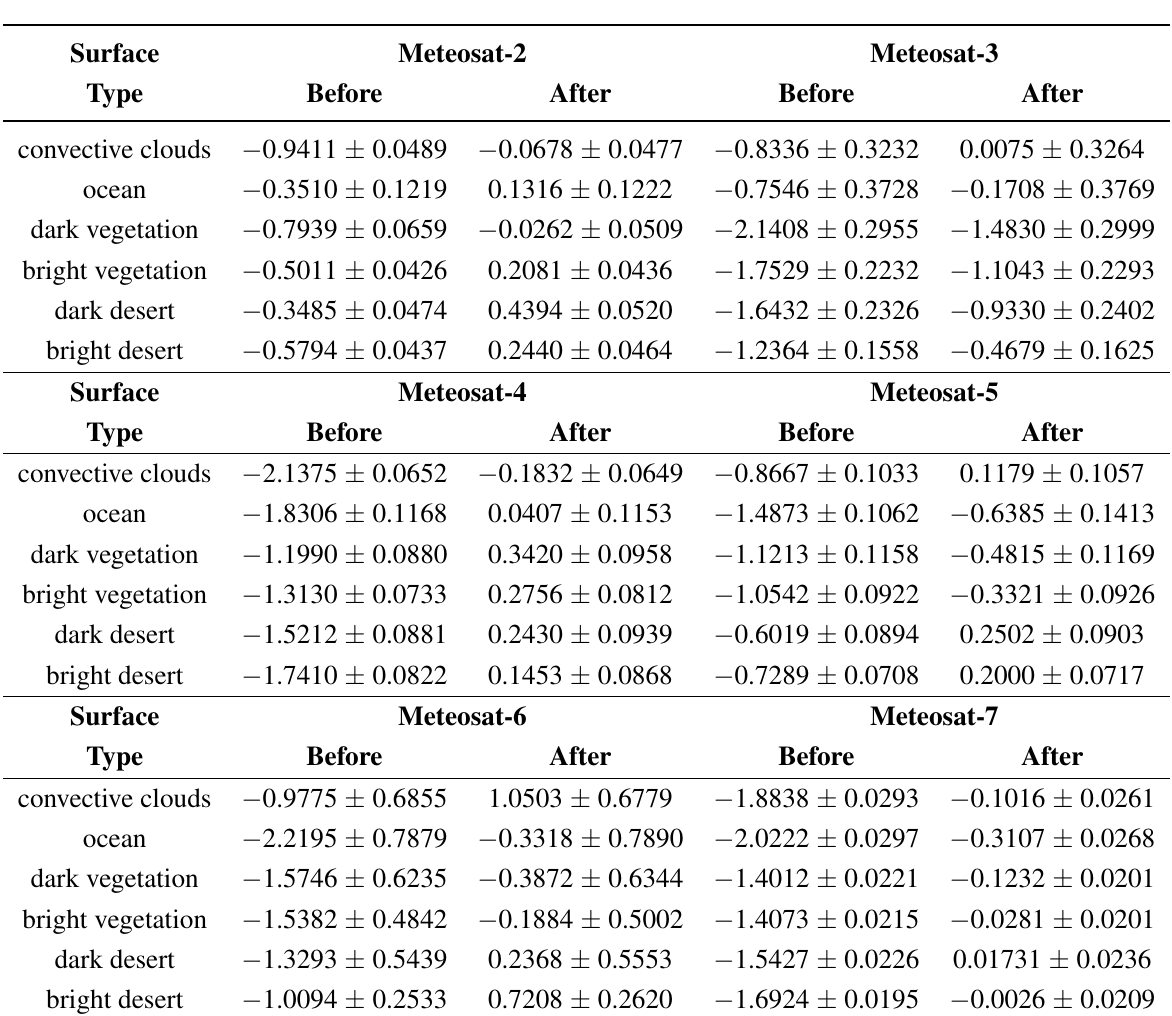
Table 4. Table giving the amount in % per year that the slopes of fits through the time series change for each MFG satellite before and after aging correction, together with the standard error on these